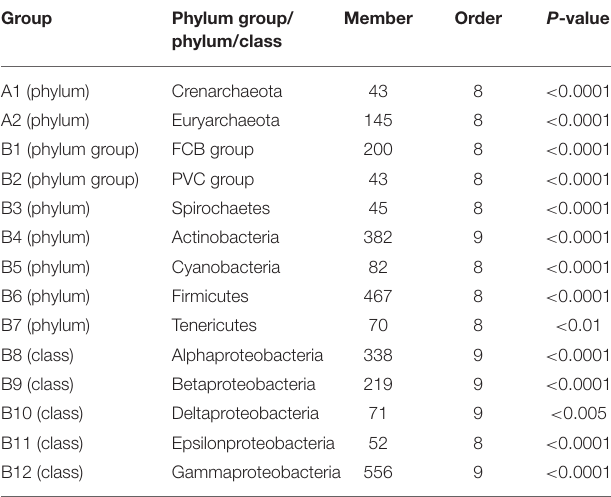
TABLE 3 | Extent of strand symmetry determined by word symmetry distance analysis ( WSD 2 and nWSD 2) in groups of archaeal and bacterial genomes classified according to their